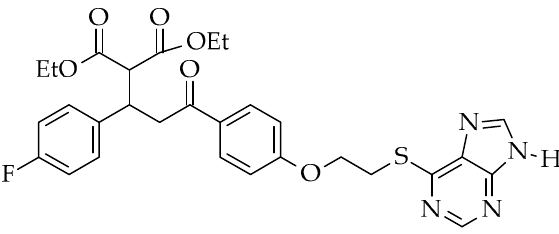
Figure 16. Structures of some synthetic antiviral chalcones. 1-(2-Benzyloxy-6-hydroxyphenyl)-3-(5-bromo-2-methoxyphenyl)-propenone ( 180 ) was found to be the most potent as an antiviral agent, and could inhibit several clinical isolates of HIV in a dose-dependent fashion with IC 50 values of around 5 μ M [105]. This finding led to further modification of this structure ( 180 ) to enhance antiviral potency and reduce toxicity towards normal human cells, which resulted in the synthesis of two more antiviral chalcones ( 181 ) and ( 182 ). Both chalcones ( 181 and 182 ) at a concentration of 10 µ M offered >92% inhibition of viral propagation without impacting host cell